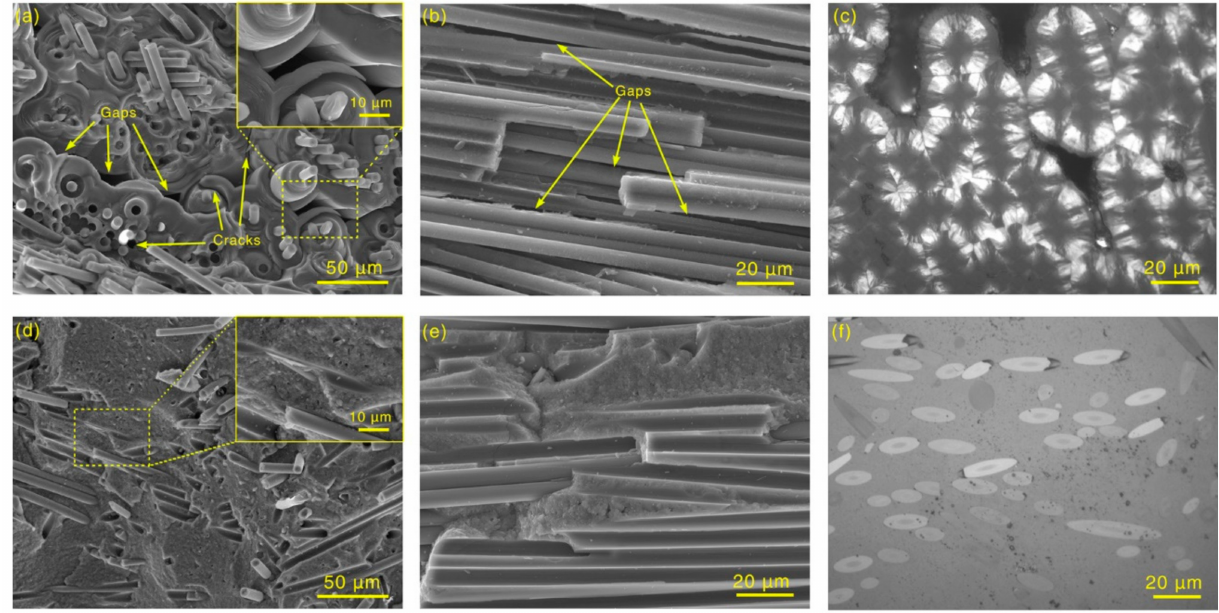
Figure 2. SEM images and PLM images of ( a – c ) C/C and ( d – f ) CC/C composites: ( a , d ) SEM images of carbon fibers perpendicular to fracture surface; ( b , e ) SEM images of carbon fibers parallel to fracture surface; ( c , f ) PLM